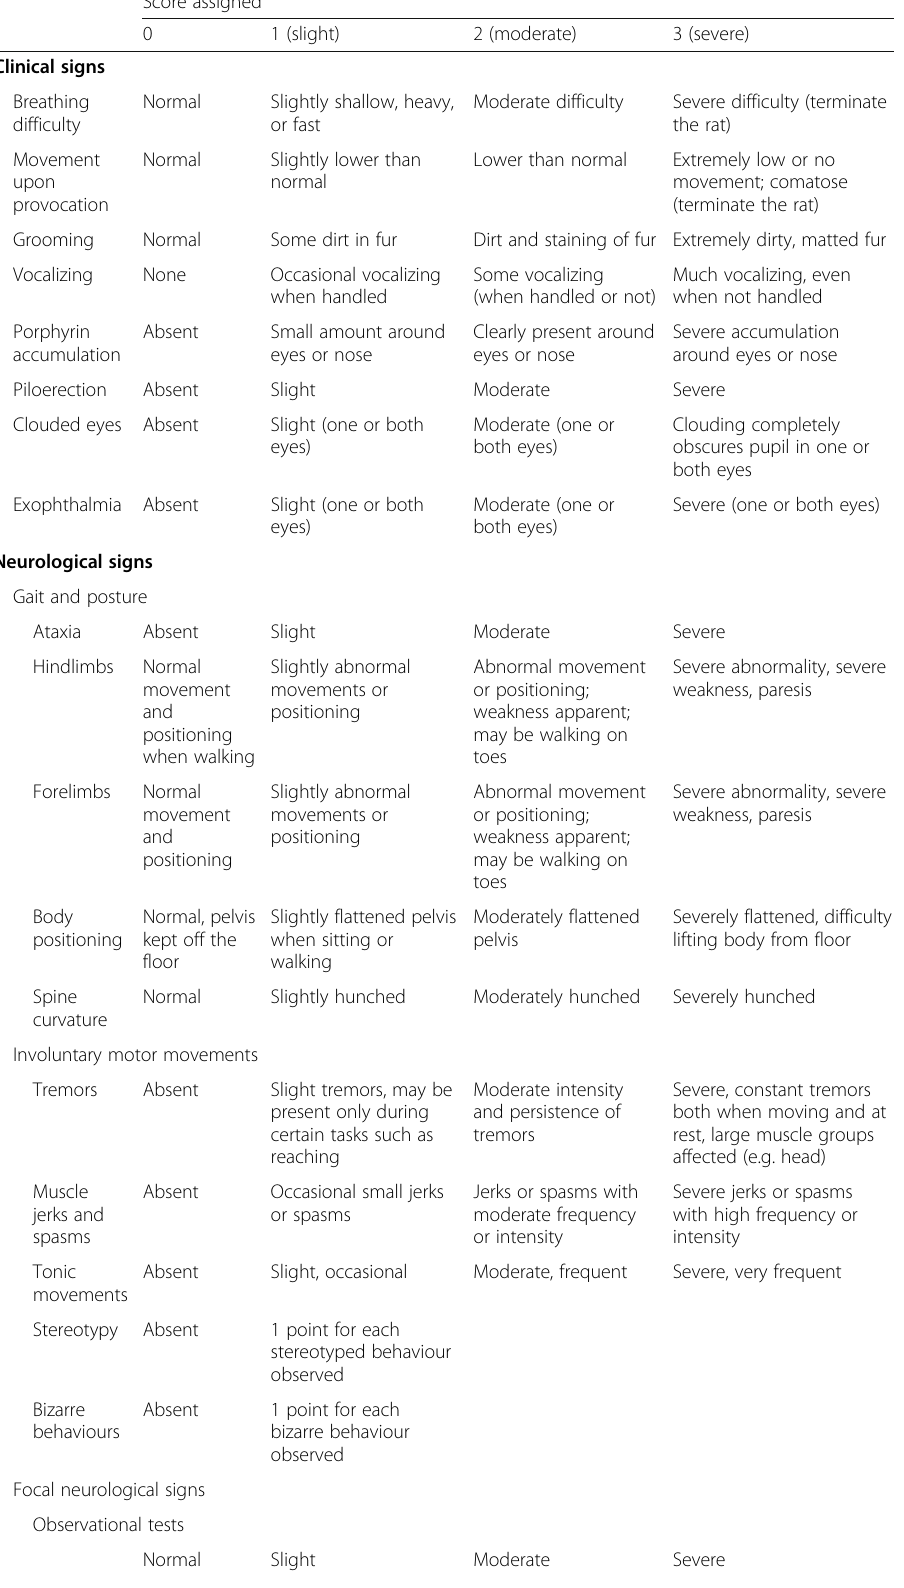
Table 2 Functional observational battery of neurological and clinical signs Score